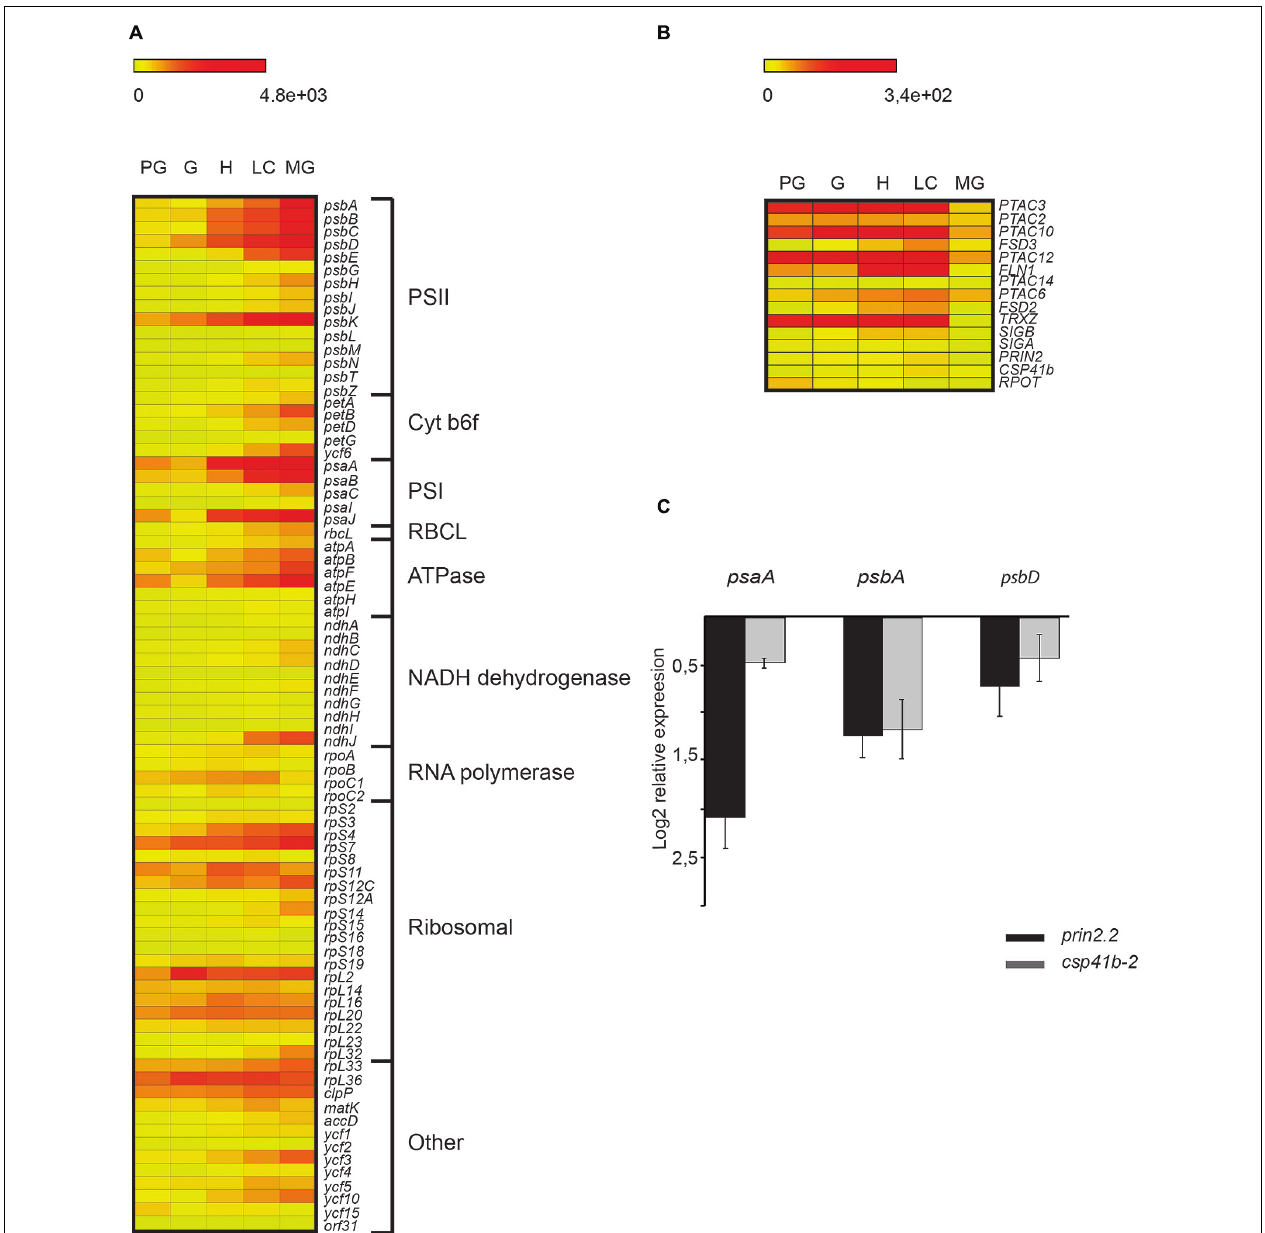
FIGURE 5 | Induction of photosynthetic gene expression during embryo development. (A) Heatmap of plastid gene expression in Col-0 embryos at different developmental stages. Scale from 0 (yellow) to 4.8.e 3 (red) represents the relative mean signal intensity for each probe (B) Heatmap of selected nuclear genes in wild type embryos at different developmental stages. Scale from 0 (yellow) to 3.4.e 2 (red) represents the relative mean